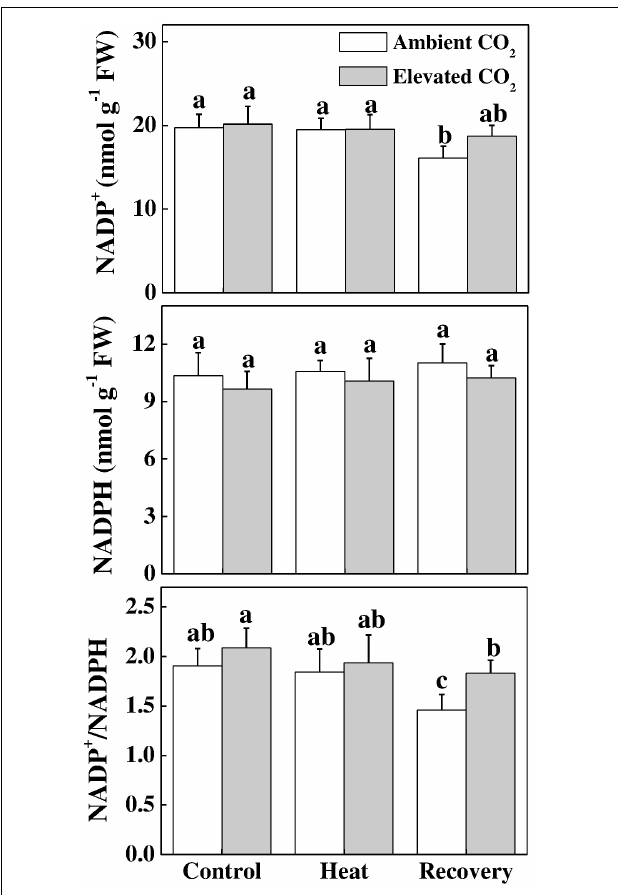
FIGURE 5 | Effects of elevated CO 2 and heat stress either alone or combined on the electron acceptor site in tomato leaves. NADP(H) concentrations were assayed after 24 h heat treatment and at 24 h recovery after the heat stress. Data are the means of four replicates ( ± SD). Mean denoted by different letters indicate significant differences between the treatments ( P <